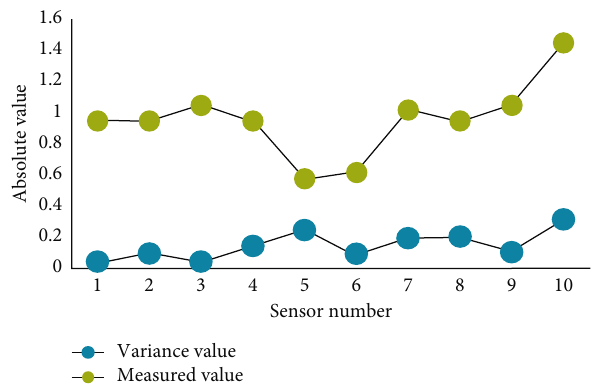
Figure 3: Measurement results and sensor variance